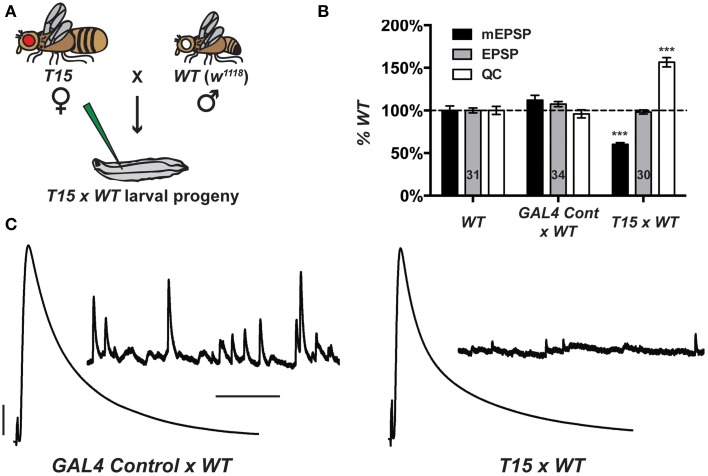
The T15 stock induces robust homeostatic compensation. (A)
T15 × WT crossing scheme. The genotype for T15 is (chromosomes X; II; III): elaV(C155)-GAL4; Scabrous-GAL4; BG57-GAL4, UAS-GluRIII[RNAi]. (B)
T15 × WT larval NMJs have decreased quantal size (***p < 0.001, T-Test vs. WT). Evoked potentials are normal because of a homeostatic increase in QC (***p < 0.001). A control stock with only GAL4 drivers behaves similarly to WT. (C) Representative electrophysiological traces. Scale bars for EPSPs (mEPSPs): 5 mV (1 mV); 50 ms (1000 ms).